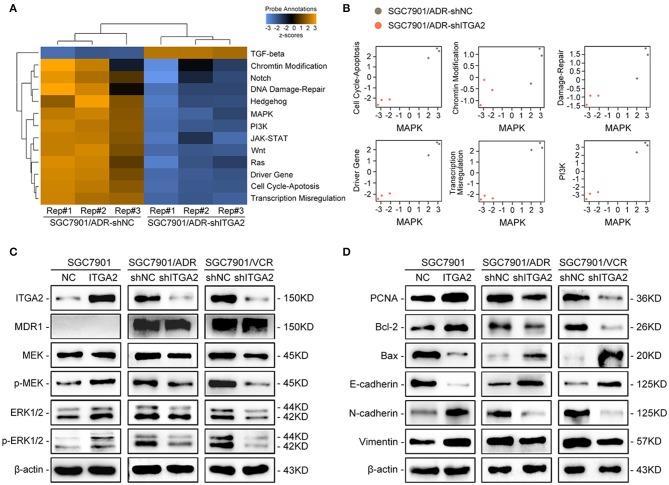
The effect of ITGA2 on the MAPK pathway in GC cells. (A,B) Heatmap and pathway panel plots summarizing the changed pathways when ITGA2 was inhibited in SGC7901/ADR cells. (C) Protein levels of MDR1 and the MAPK pathway markers were measured in SGC7901 cells with ITGA2 overexpression and in SGC7901/ADR and SGC7901/VCR cells with inhibited ITGA2 expression. (D) Protein levels of EMT biomarkers and apoptosis biomarkers in SGC7901 cells with ITGA2 overexpression and in SGC7901/ADR and SGC7901/VCR cells with inhibited ITGA2 expression.